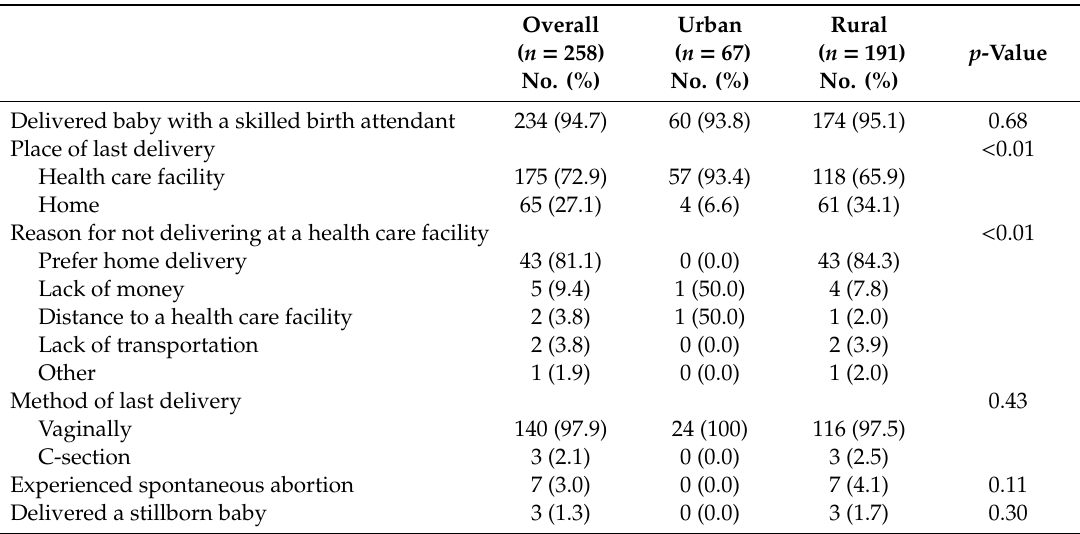
Table 4. Labor and